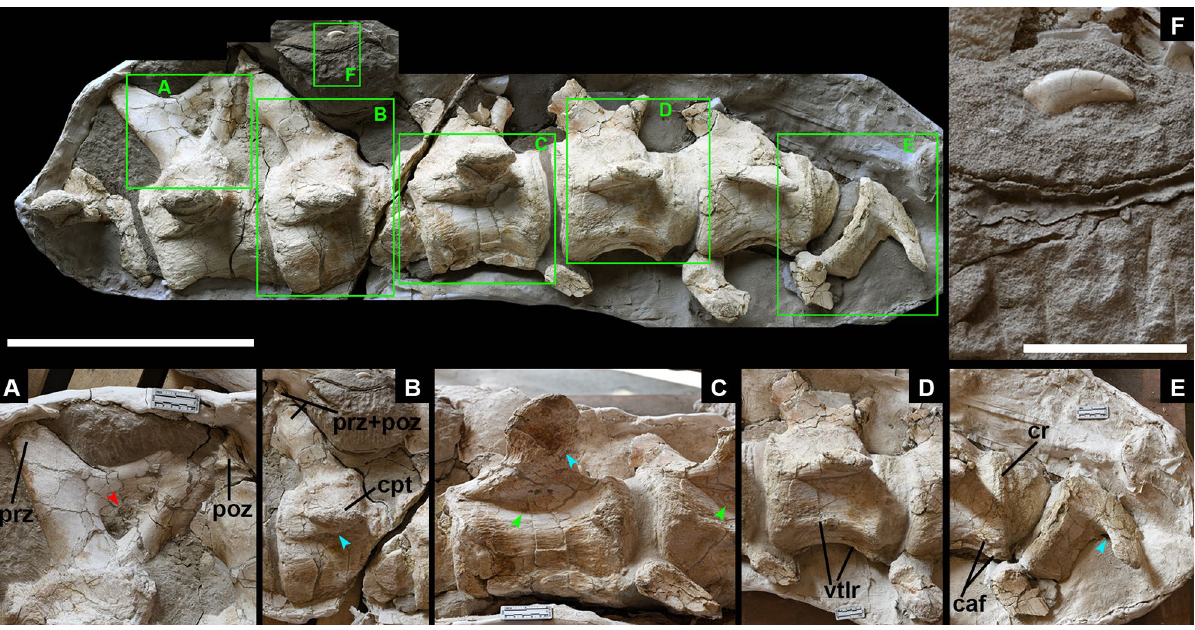
Figure 4. Hamititan xinjiangensis gen. et sp. nov., caudal sequence (HM V22) in right lateral view. Squares separated by letters indicate relevant anatomical details. ( A ) Neural arch of the 6th caudal showing pneumatic fossa, open inner small cavities, and the preserved prezygapophysis (prz) and postzygapophysis (poz). ( B ) Detail of the prezygapophyseal (prz) and postzygapophyseal (poz) articulations, and the upward oriented caudal transverse process (cpt). ( C ) Detailed of the caudal transverse process (cpt), with a smooth tuberosity at its ventral face (blue arrow). Green arrows show excavated lateral centra. ( D ) The pronounced ventrolateral ridges (vtrl) found at the anterior to middle caudal vertebrae. ( E ) Transverse processes abruptly changing from upward to downward on the 10th and 11th caudal vertebrae (blue arrow). The 10th caudal vertebra also shows a distinctive condylar rim (cr), and a developed chevron articulation facet (caf). ( F ) The theropod tooth that was found in association with this specimen. Scale bar: 50 cm for the whole specimen and 5 cm in ( F ). Maximum length Maximum height Neural arch heigth Centrum height